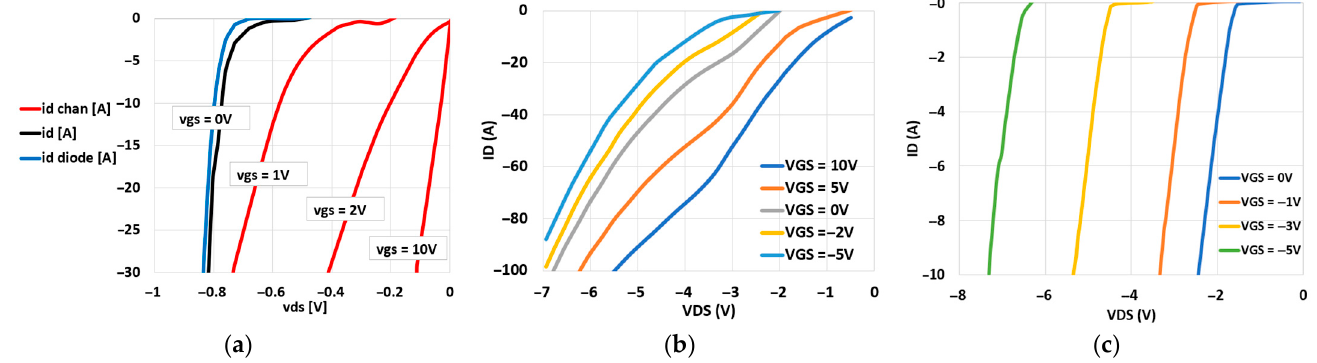
Figure 7. Third quadrant conduction of ( a ) Si MOSFET: total drain current (black curves) is the sum of the body diode current (blue curve) and the channel current (red curves) [50]; ( b ) SiC MOSFET (STMicroelectronics SCTH35N65G2V7) [51]; ( c ) GaN HEMT (Infineon IGO60R070D1) [52].